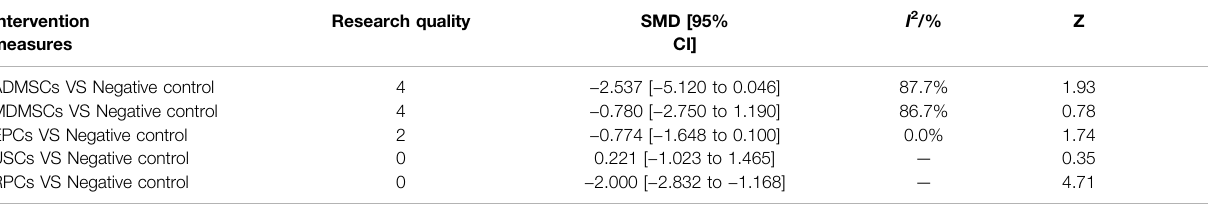
TABLE 5 | Traditional Meta-analysis results of serum creatinine levels between stem cell groups and the control group at 14 days after administration.